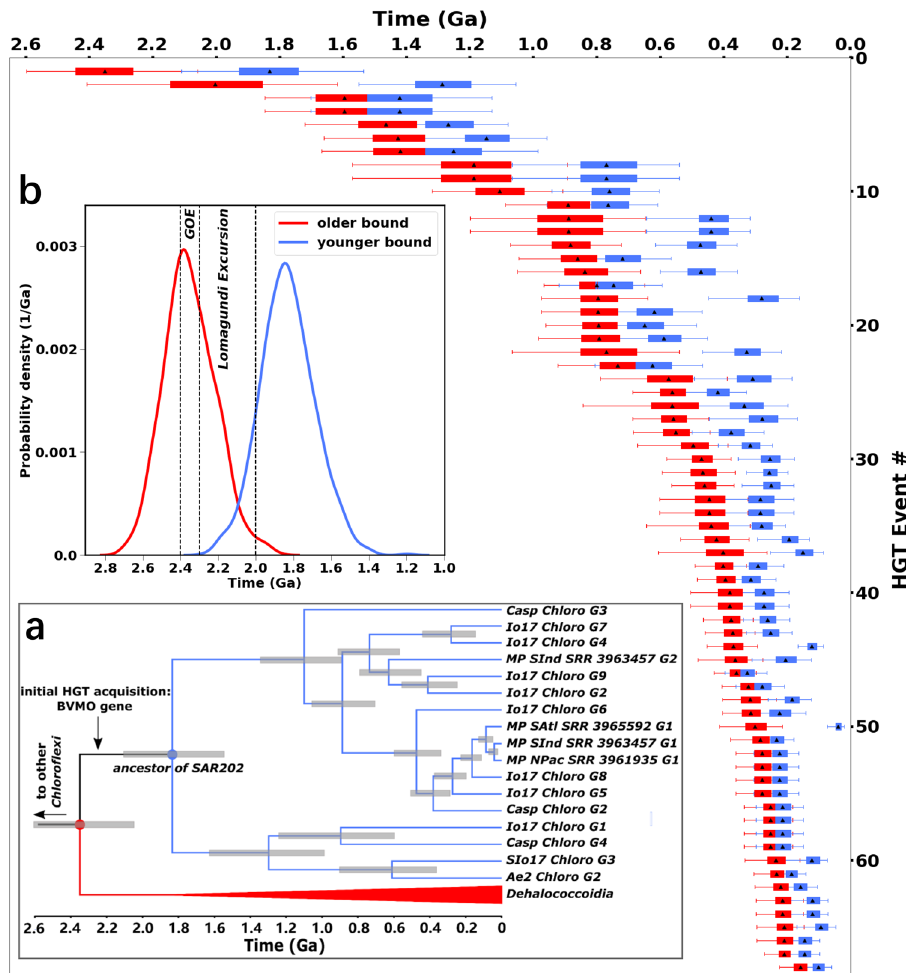
Fig. 3 Phylogenetic and molecular clock analyses for the Baeyer – Villiger monooxygenases (BVMOs) of the SAR202 cluster bacteria and their closely related microbial species. The main fi gure shows a graphic summary for weighted means and 95% con fi dence intervals (CIs) of the older and younger time bounds ( n = 1023 posterior samples for the BVMO gene tree chronogram) for 68 inferred horizontal gene transfer (HGT) events between/within the Chloro fl exi, Actinobacteria, and Proteobacteria phyla presented in Supplementary Information, Supplementary Table 5. The directions (i.e., donors and recipients) of these HGT events are provided in Supplementary Table 6. In the main fi gure, red and blue boxes represent older and younger time bounds, respectively. The right and left bounds of each box are the 25th and 75th percentiles, respectively; the right and left whiskers mark the 2.5th and 97.5th percentiles, respectively; the black triangles represent means. a A subtree of calibrated chronogram showing SAR202 (blue) and related Dehalococcoidia group (red); the complete chronogram is provided in Supplementary Fig. 4. The initial HGT acquisition (also illustrated in Supplementary Fig. 7) occurred on the branch between stem SAR202 node (red fi lled circle) and crown node SAR202 (blue fi lled circle). Gray horizontal bars on the nodes indicate 95% CIs ( n = 1023 posterior samples for the BVMO gene tree chronogram). b The posterior date intervals of the older and younger age bounds for the initial HGT event into SAR202 (i.e., the stem (red) and crown (blue) SAR202 nodes in ( a )). Stem and crown date intervals correspond to the distributions of older (red) and younger (blue) time bounds for the initial HGT acquisition shown in ( a ), and also correspond to the HGT event # 1 shown in the main fi gure. The mean date of older bound is 2350 Ma (95% CI: 2056 Ma – 2598 Ma), and the mean date of younger bound is 1830 Ma (95% CI: 1535 Ma – 2110 Ma), where n = 1023 posterior samples for the BVMO gene tree chronogram. The time windows of the Great Oxidation Event and the Lomagundi Excursion Event overlap the distributions of older and younger time